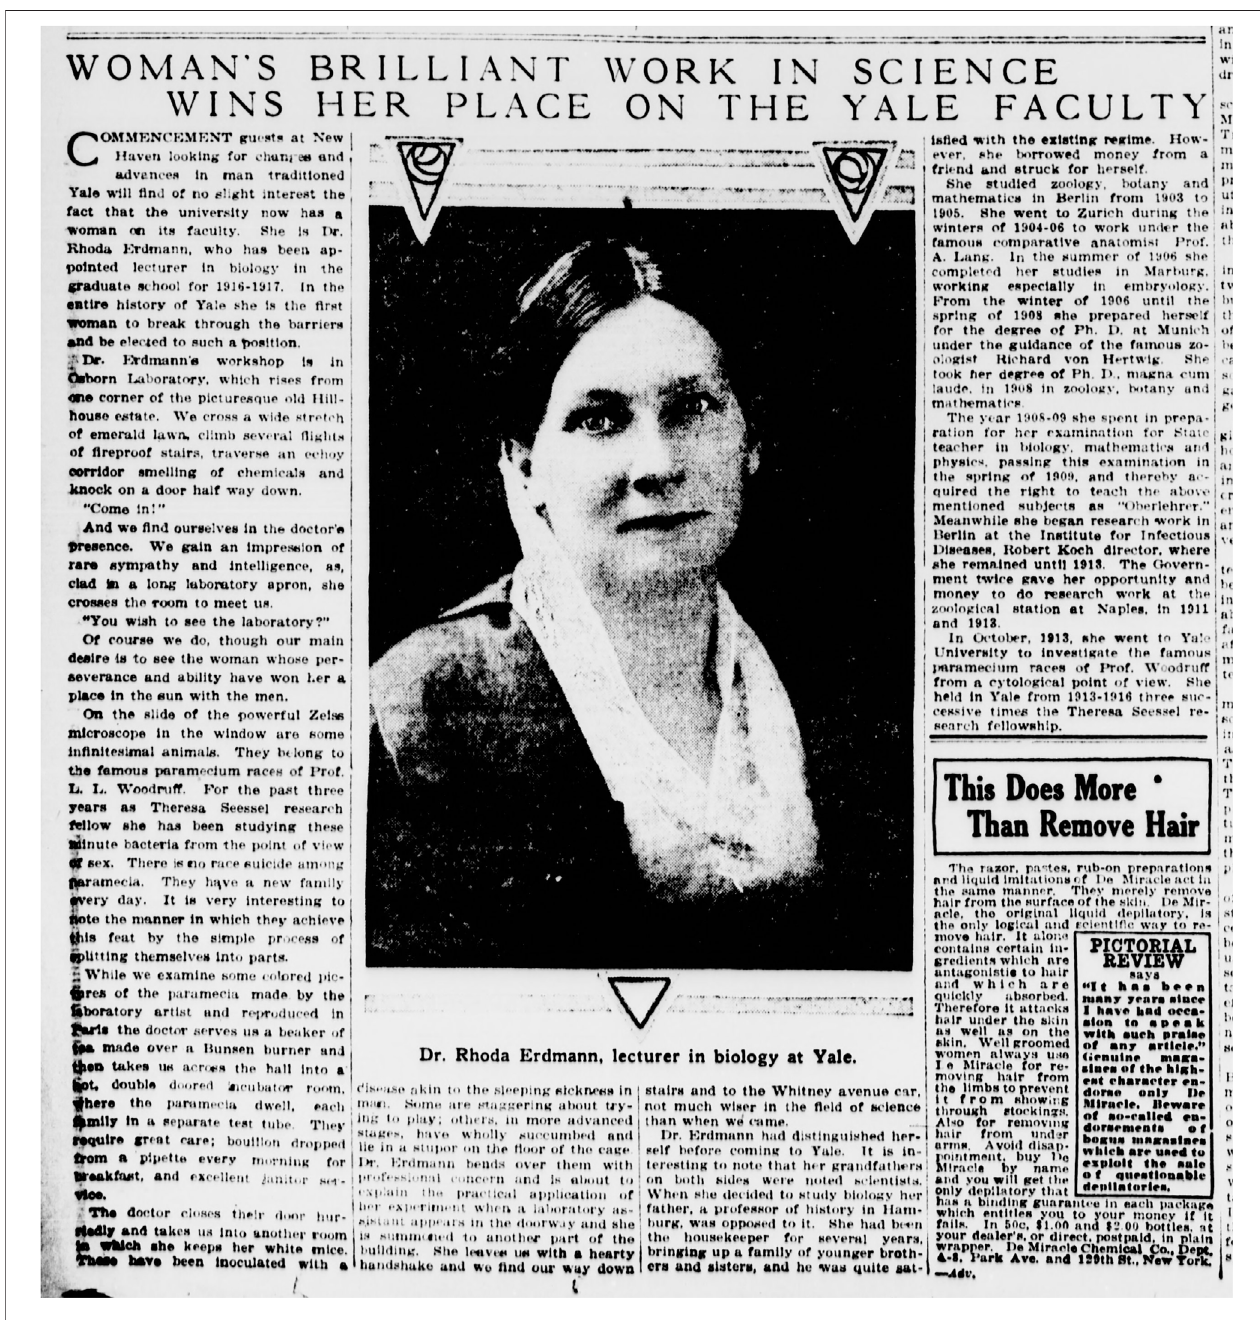
FIGURE 2 | Article about Erdmann ’ s appointment and work at Yale. The Sun (New York [N.Y.]), 11 June 1916, page 6 (https://chroniclingamerica.loc.gov/lccn/ sn83030272/1916-06-11/ed-1/seq-26/ accessed 27.11.2021).